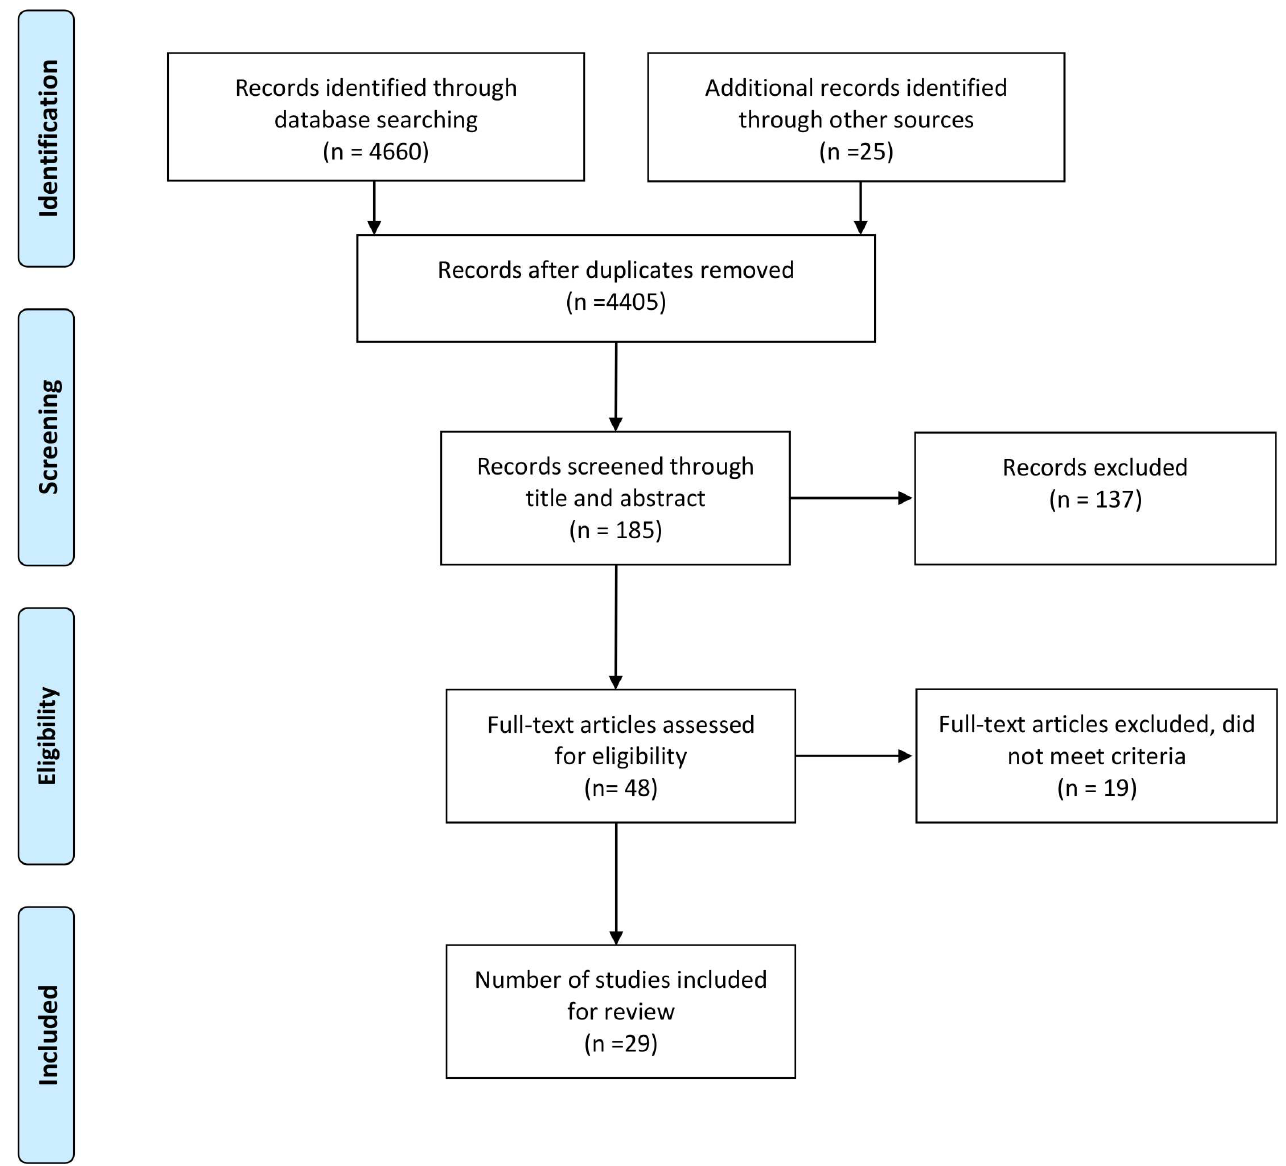
Fig 1. PRISMA Flowchart for the selection of studies included in the systematicreview.